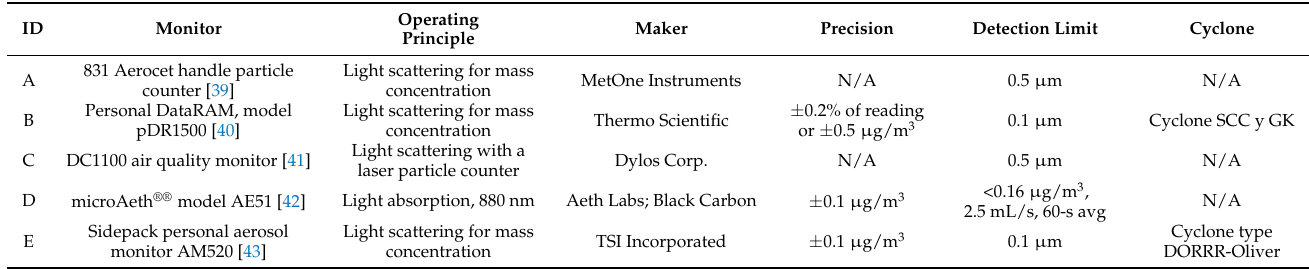
Table 1. Commercial personal environmental